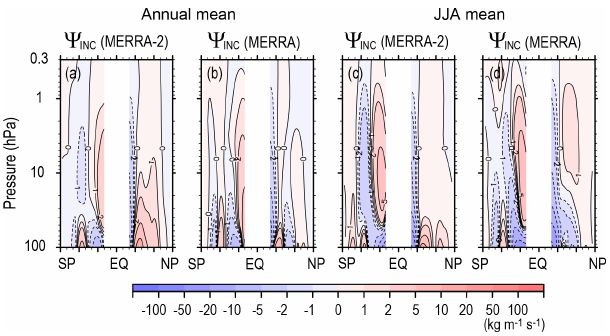
Figure 15. Meridional cross sections of the climatology of the an- nual mean stream function due to an assimilation increment for zonal mean zonal wind tendency for MERRA-2 and MERRA (a, b) and of the JJA mean (c, d)